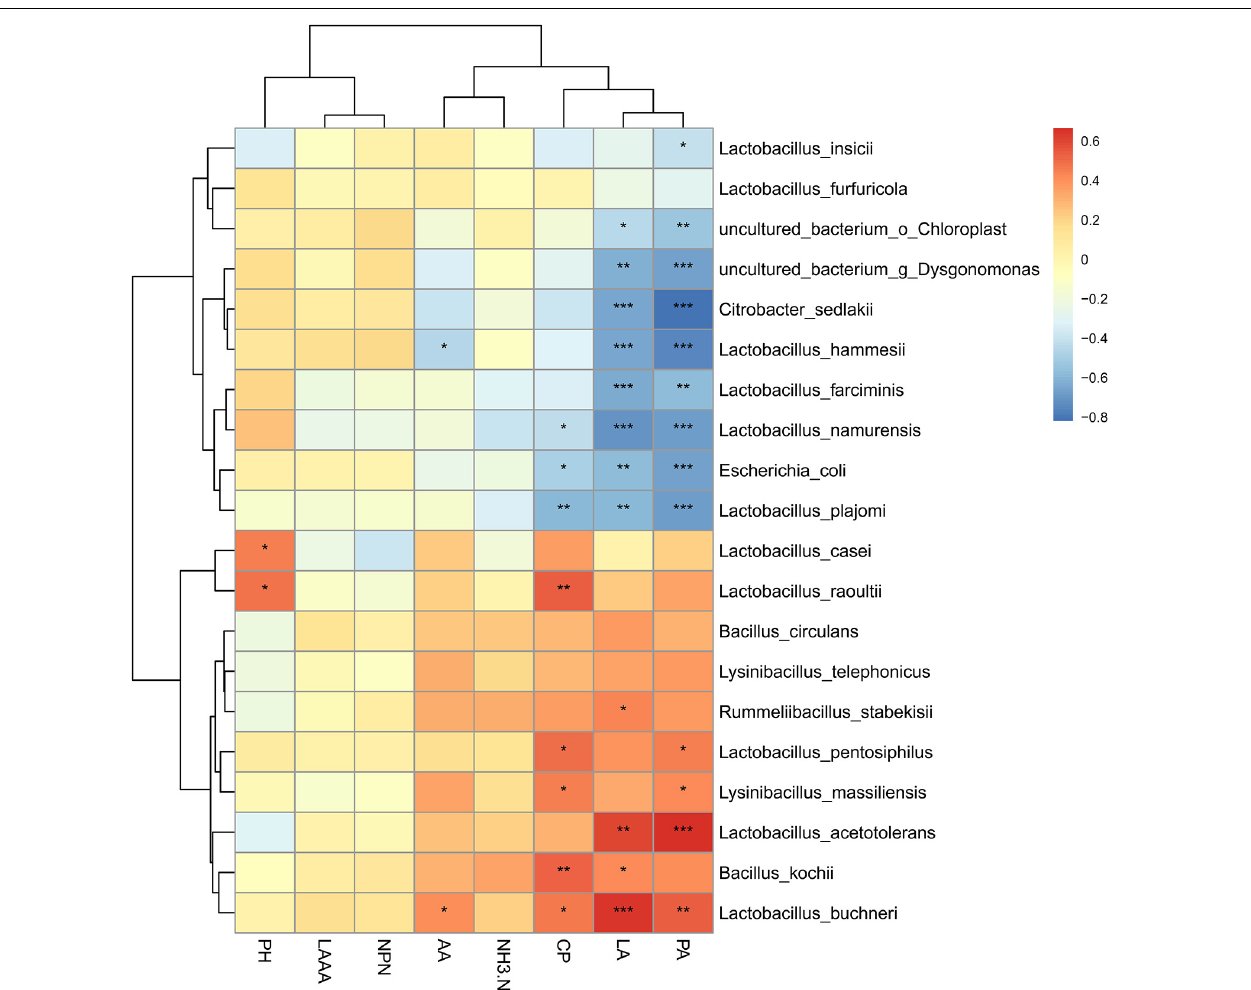
FIGURE 4 | Correlation analysis between bacterial community and fermentation products in paper mulberry silage. Corresponding value of middle heat map is Spearman correlation coefficient r, which ranges between 1 and 1, r < 0 indicates a negative correlation (blue), r > 0 indicates a positive correlation (red), and *, **, and *** represent P < 0.05, P < 0.01, and P < 0.001, respectively.